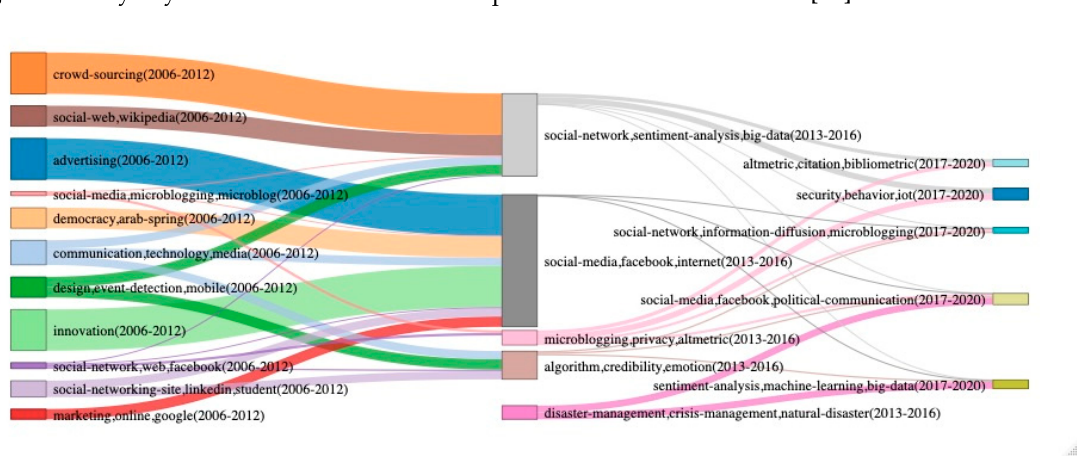
Figure 7. Alluvial diagram of thematic evolution.